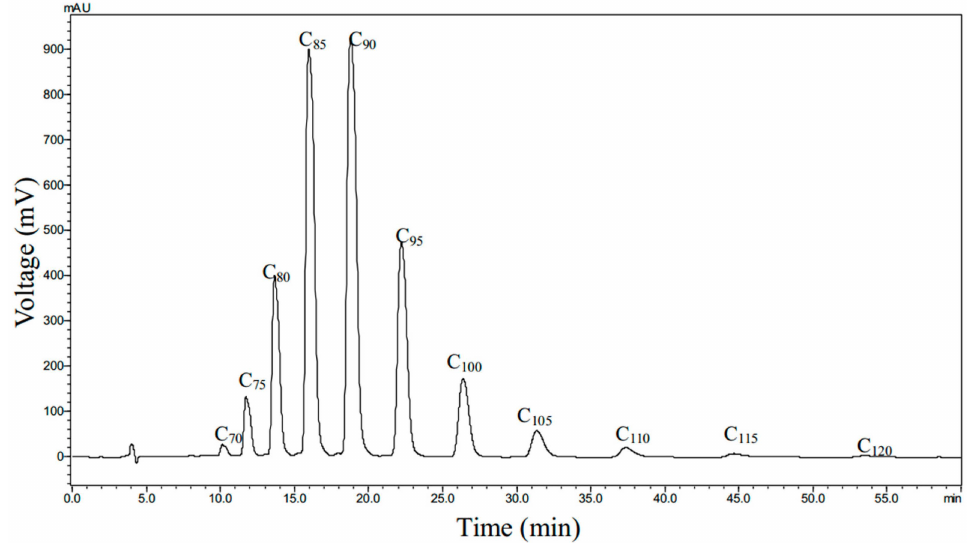
Figure 2. HPLC of